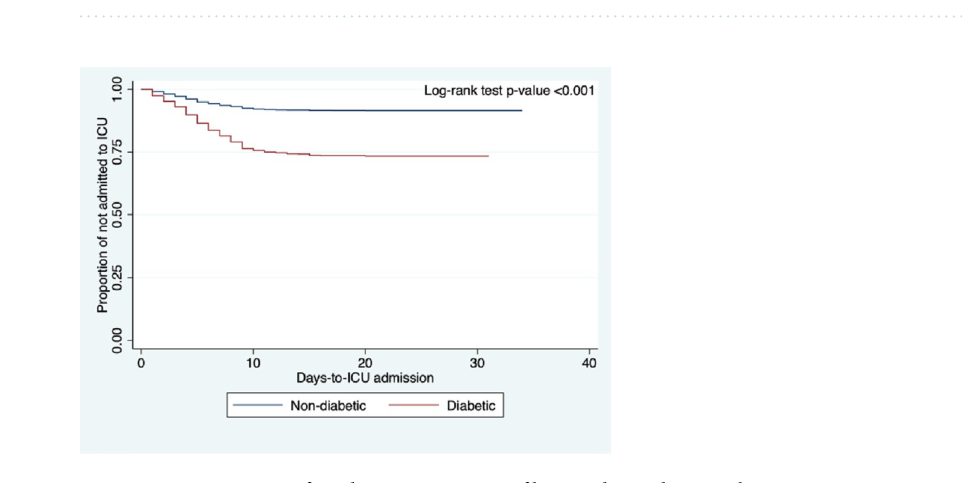
Figure 2. Comparison of Kaplan–Meier curves of respiratory failure between COVID-19 patients with diabetes versus non-diabetics, adjusted for the different confounding variables of interest.